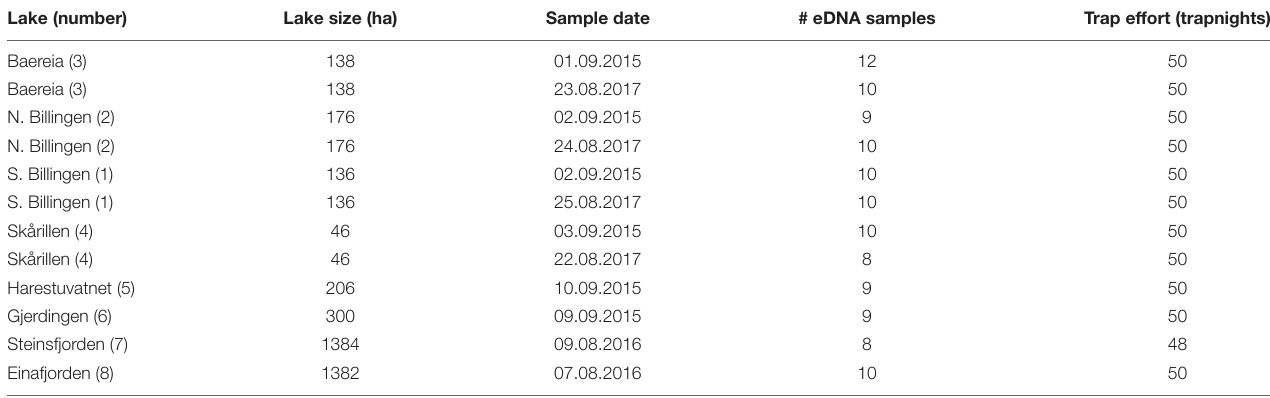
FIGURE 1 | (A) Location of the monitored lakes in Norway. Black dots indicate the lakes and numbers identify the lakes, referring to Table 1 . (B) Illustration of sampling transect of crayfish trapping and eDNA sampling at location 8. Here, 50 traps were set along the shoreline in the gray shaded area, and 8–10 filtrated water samples (black dots) were collected from each lake. TABLE 1 | Lake and lake size with sample dates and effort of eDNA samples and